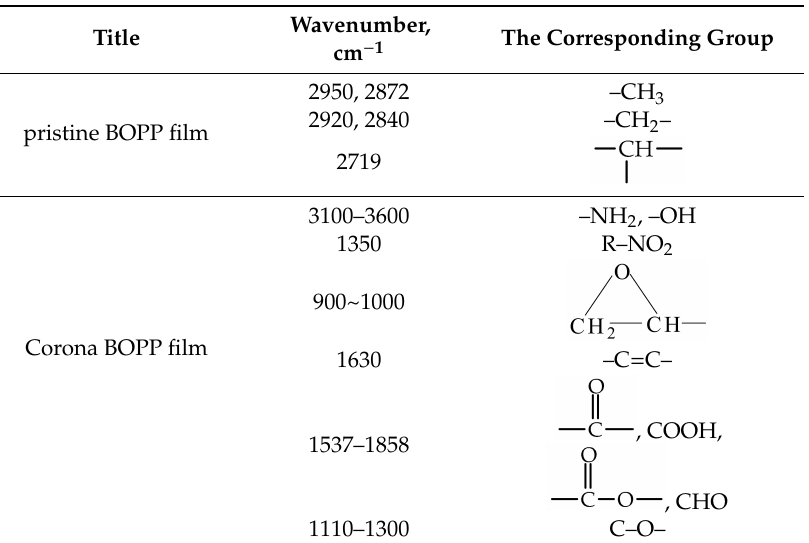
Table 2. The ATR-FTIR results of pristine BOPP film and corona BOPP film.